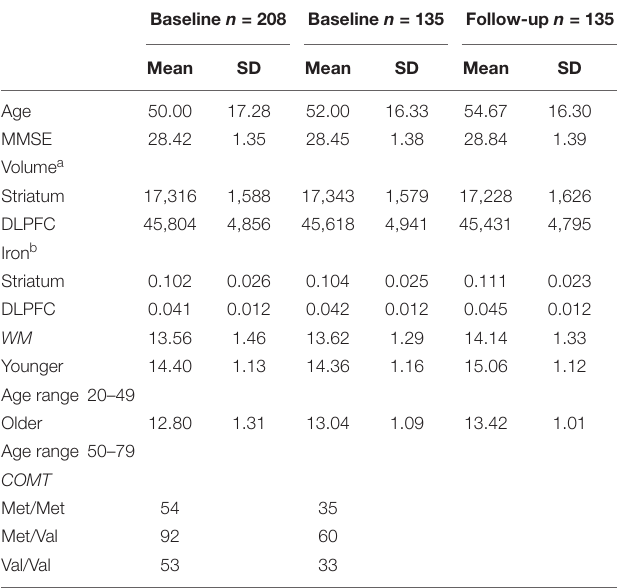
TABLE 1 | Participant characteristics for the total sample and the sample with available follow-up